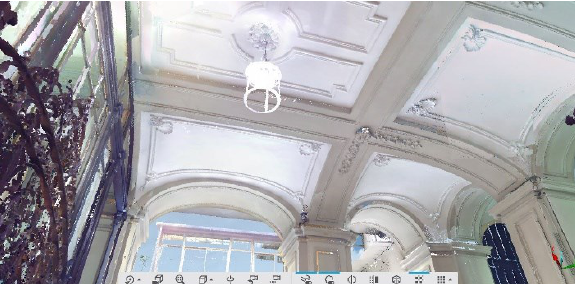
Figure 7. Image extracted from the point cloud. The resulting point clouds acquire a photographic realism. Scanning: M. C. López González. Processing: F.